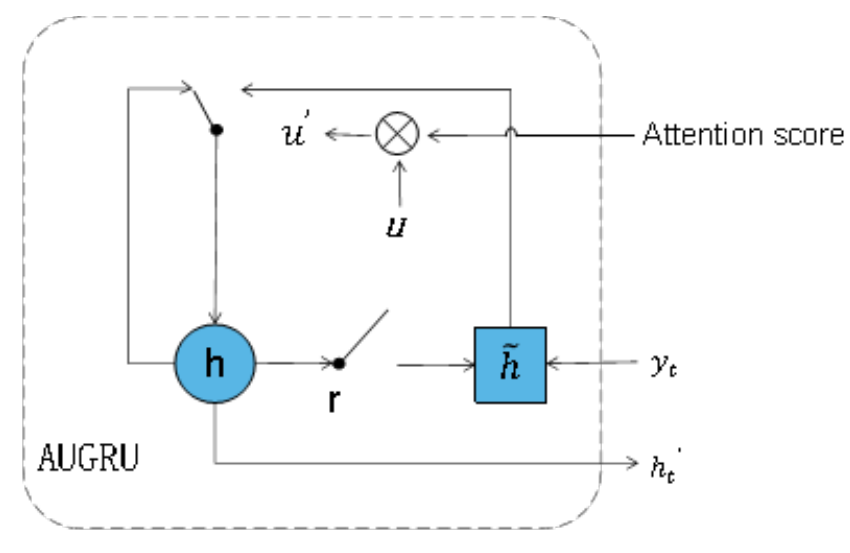
Figure 5. A schematic diagram of AUGRU